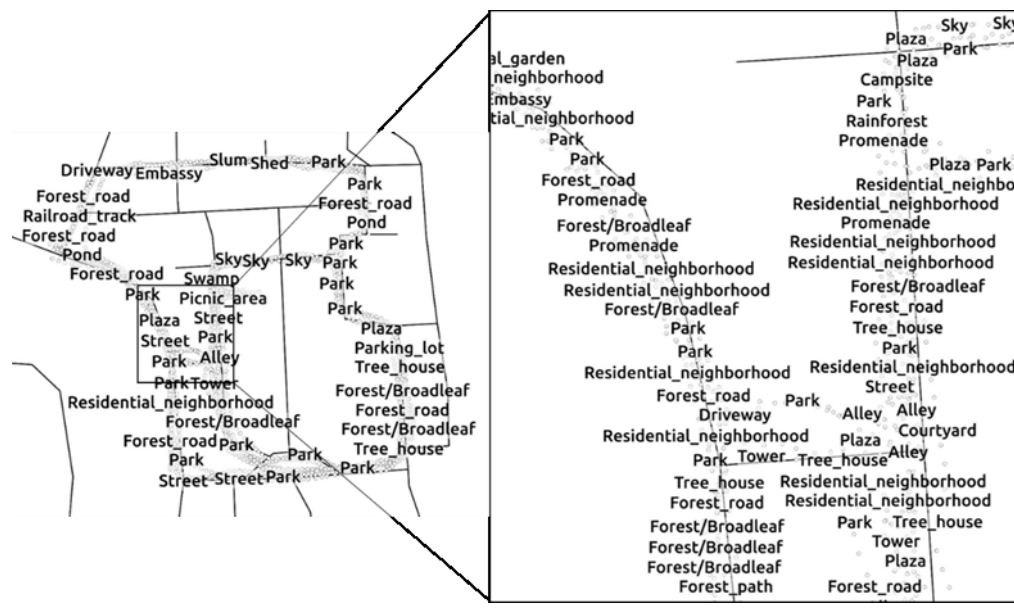
Figure 7. Snippets of maps showing places identified.